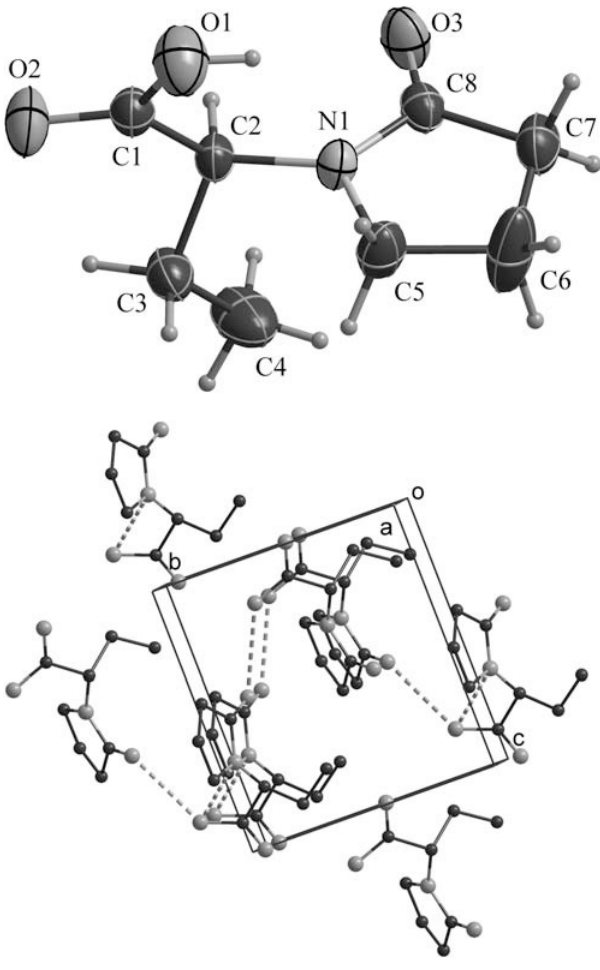
Table 2. Atomic coordinates and displacement parameters (in Å 2 )